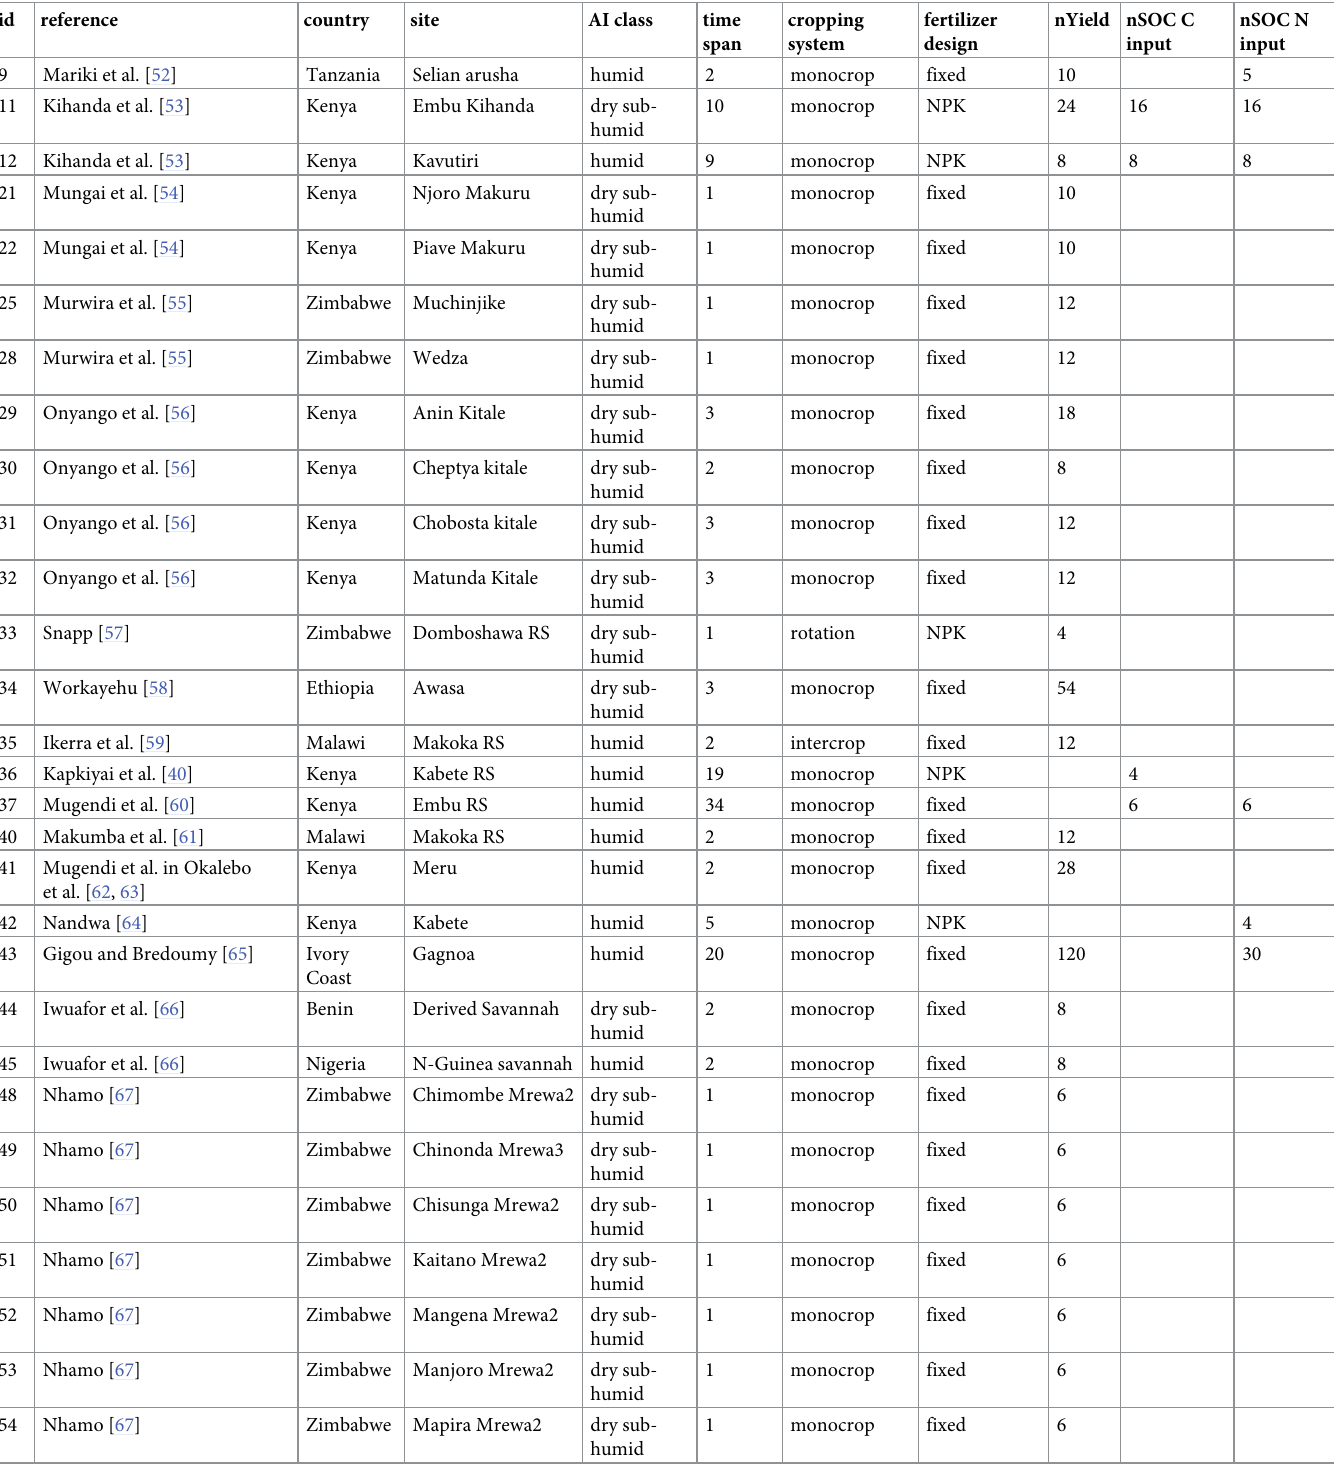
Table 1. Overview of the data set used for the YIELD and SOC meta-analyses, with columns for the study � country � site combination index (id), study (reference), aridity index class (AI class) � , time span of the study’s experiment (time span), number of yield data (nYield), number of SOC data associated with C and N